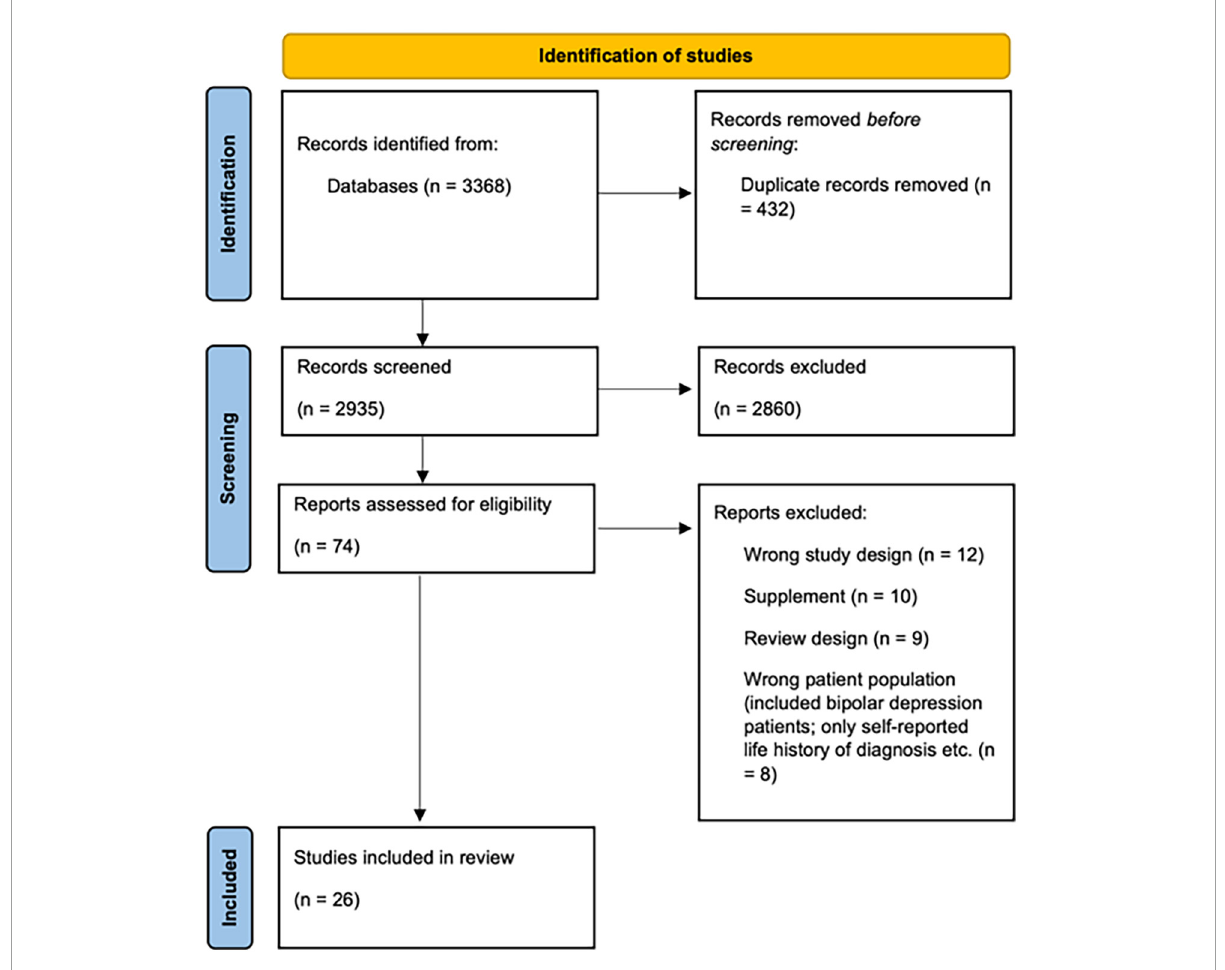
FIGURE1 Prisma flow chart shows the process of identification of